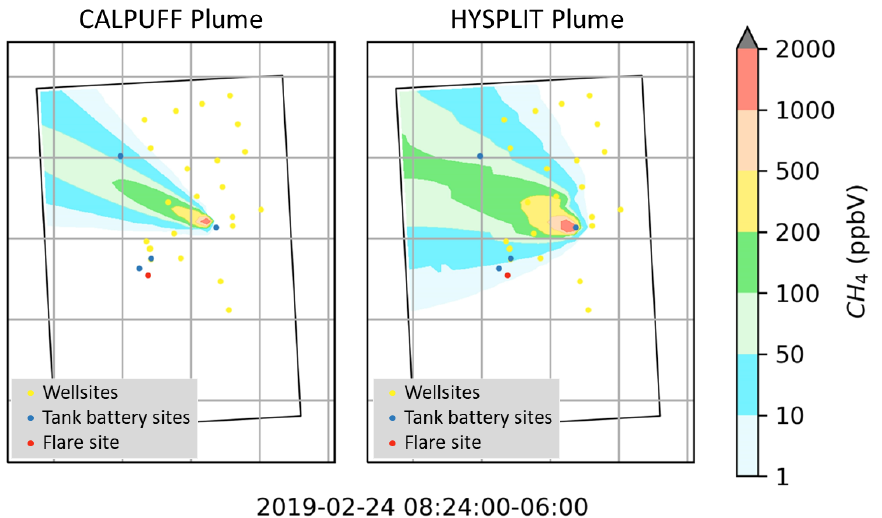
Figure 4. Comparison of methane plumes predicted by CALPUFF and HYSPLIT models at a minute instance during the simulation week in winter, due to a continuous emission source with an emission rate of 25 kg/h at the tank battery site in the middle of the study domain.